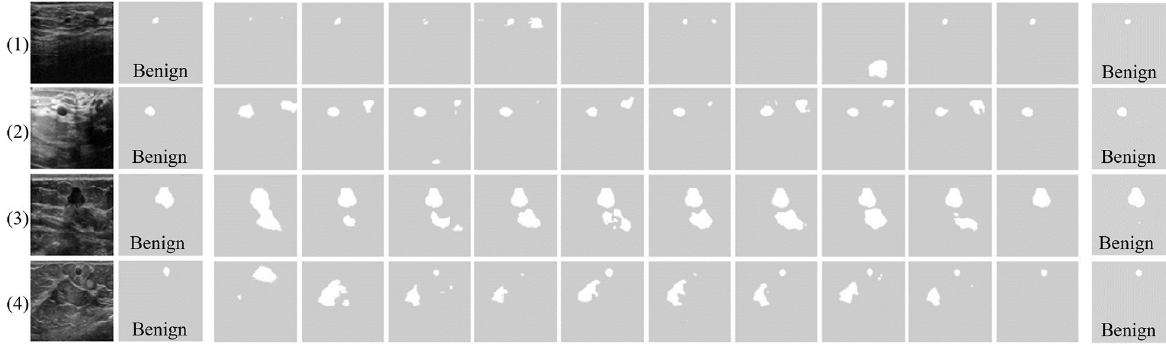
Fig 10. Examples of results compared with the state-of-the-art methods on BUS image public datasets. The state-of-the-art results are from [54] and the results for CTG-Net are from this present study. (a) BUS images, (b) ground truth (white areas are lesions and text are true class labels). (c)– (m) Segmentation results achieved by (c) FCN-AlexNet, (d) SegNet, (e) U-Net, (f) CE-Net, (g) MultiResUNet, (h) RDAU-Net, (i) SCAN, (j) DenseU-Net, (k) STAN, (l) ESTAN, and (m) our CTG-Net.